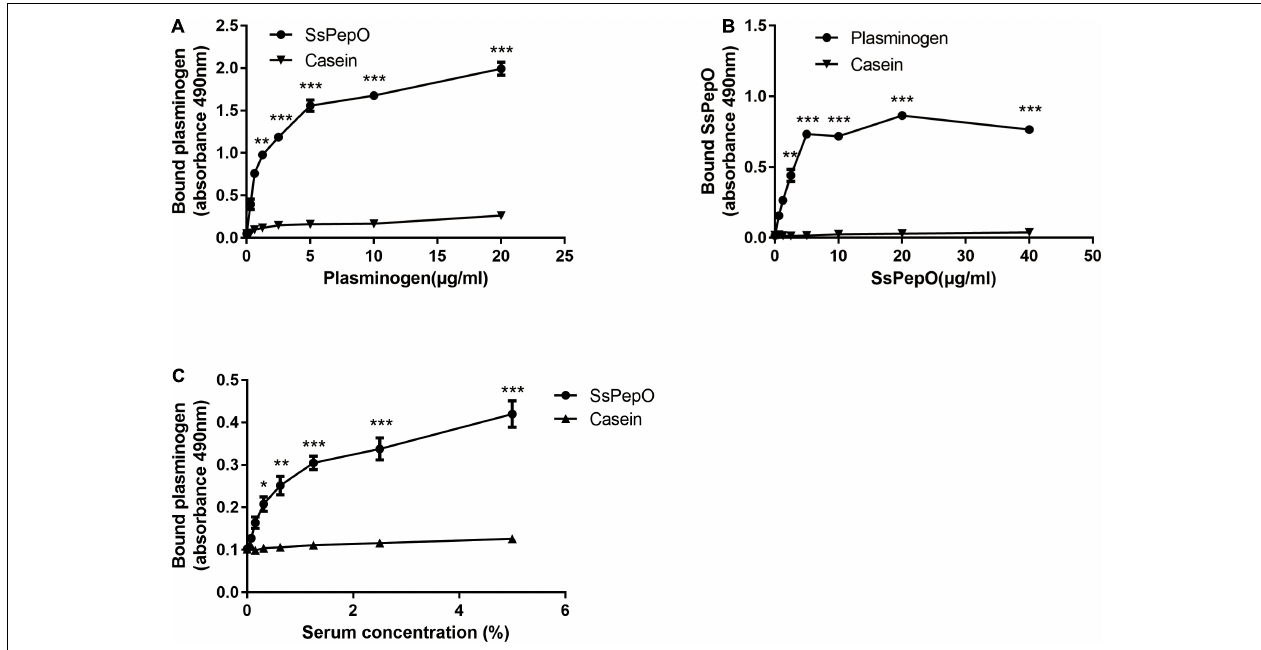
FIGURE 1 | Plasminogen binding to S. suis protein endopeptidase O (SsPepO). (A,B) Microtiter plates were coated with either SsPepO (5 µ g/ml) (A) or plasminogen (5 µ g/ml) (B) , and increasing amounts of plasminogen or SsPepO, respectively, were added. (C) The binding of plasminogen to SsPepO from human serum was assessed. Microtiter plates were coated with SsPepO (5 µ g/ml), and increasing amounts of serum was added. These assays were repeated three times, and the results were represented as the mean ± SD. ns, not significant; * p < 0.05; ** p < 0.01; *** p < 0.001.